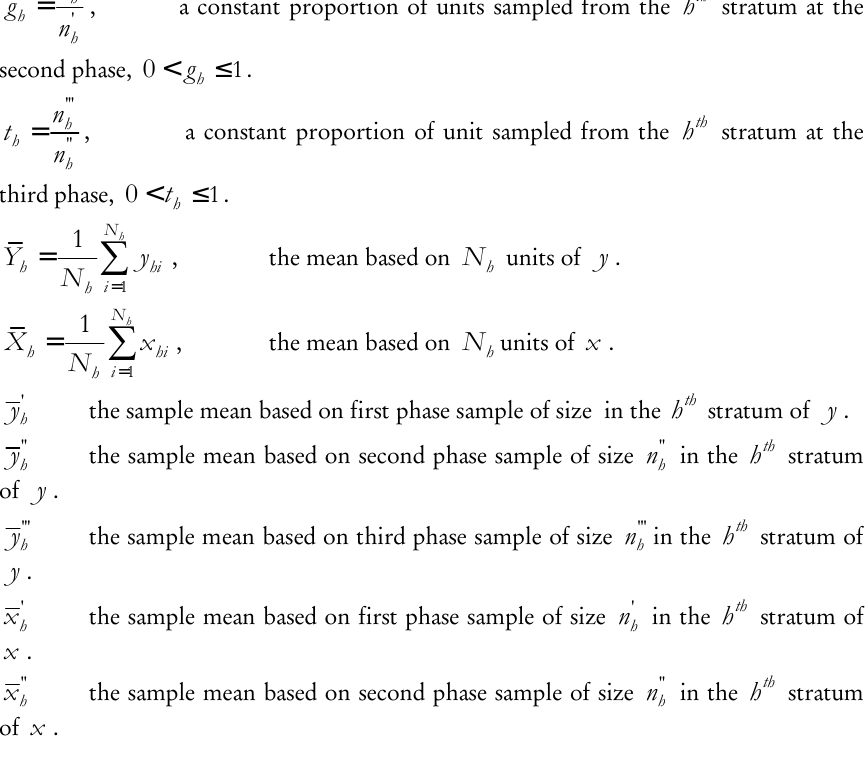
the number of units in a subsample cond phase to observe an auxiliary variable x . the number of units in a subsample third phase to observe the main character y